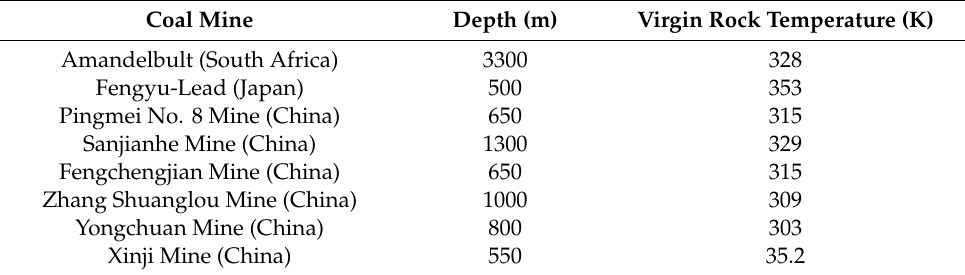
Table 1. Statistics for thermal disasters in some